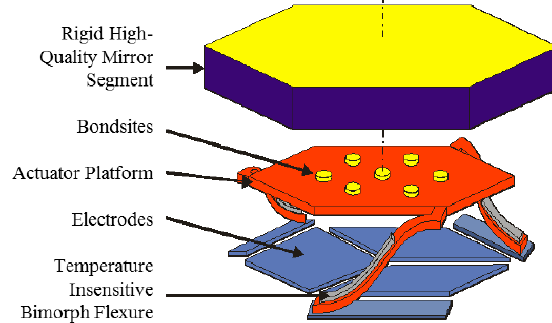
Figure 4. Exploded-view schematic diagram of a 700 µm circumscribed diameter (606.2 µm flat-to-flat pitch) mirror segment. Scaling is highly exaggerated in the vertical direction. Actuator platform heights are in the range of 20–40 µm for these segments, which enables 8 µm of stroke.